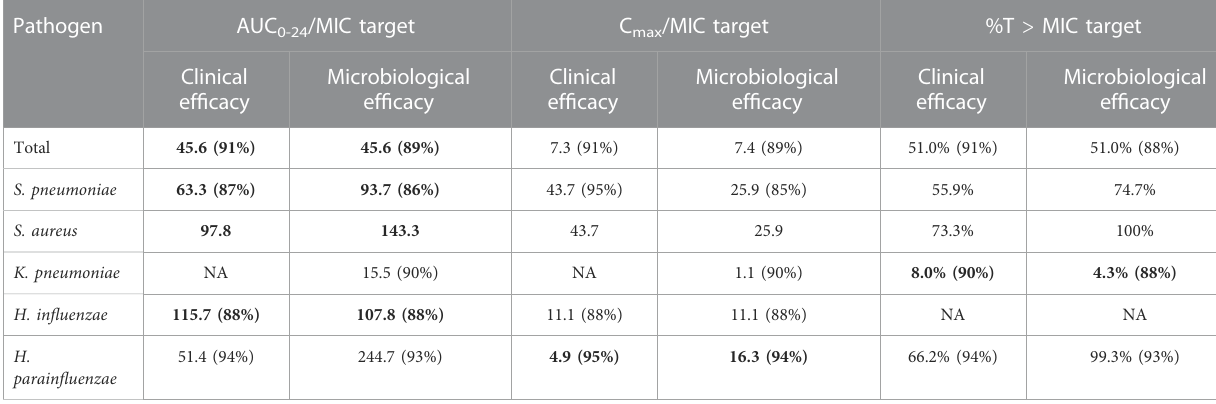
TABLE 3 Nemonoxacin PK/PD target against Gram positive and negative